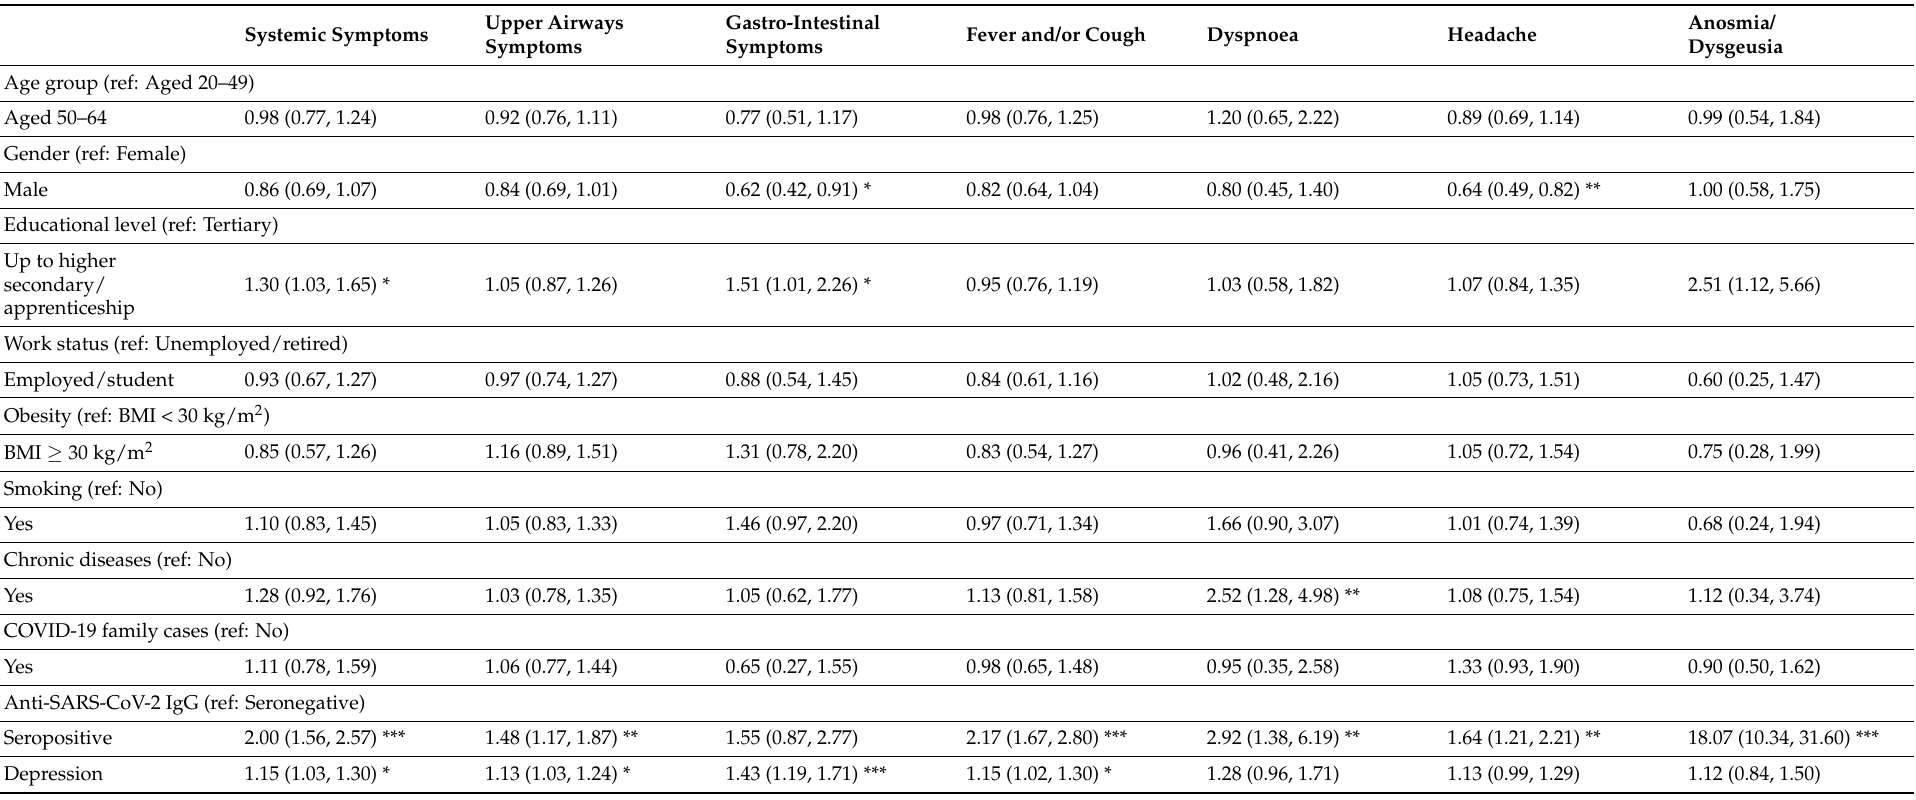
Table A4. Prevalence ratios (95% confidence intervals) from Poisson regressions estimating likelihoods of reporting COVID-19 symptoms at baseline